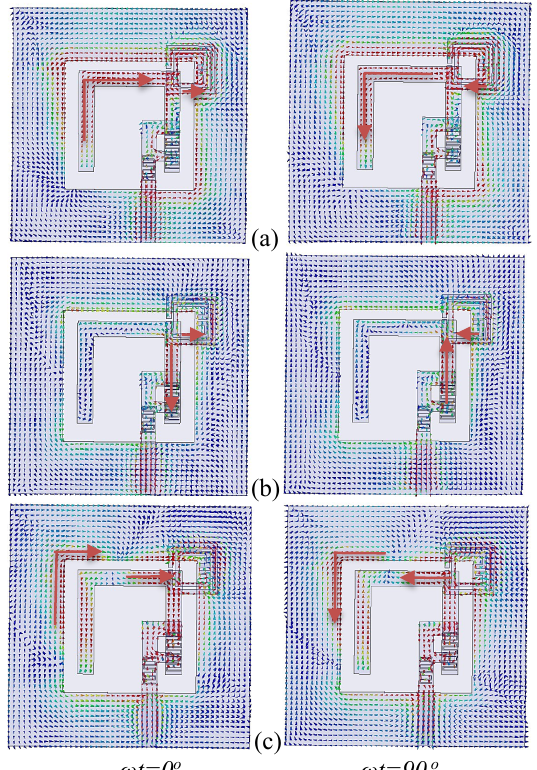
Figure 5: Simulated surface current distribution for the proposed antenna at: (a) 1.5 GHz, (b) 2.75 GHz, (c) 3.16